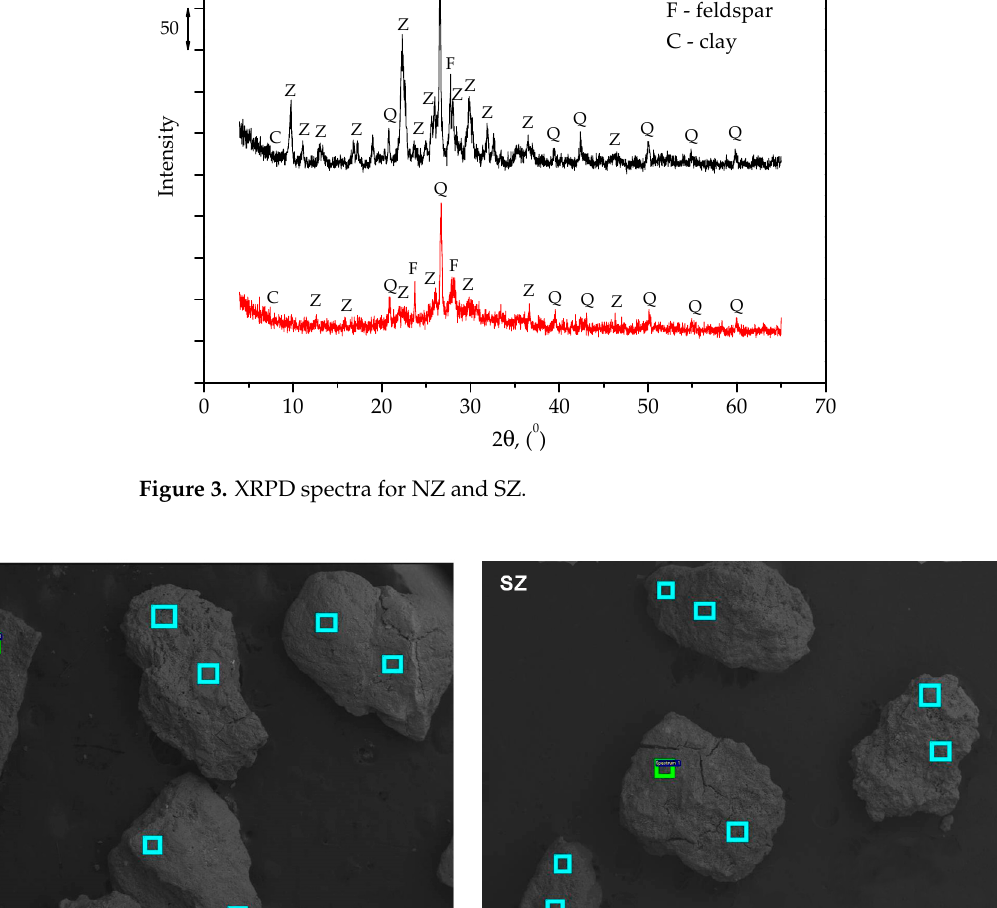
Figure 3. XRPD spectra for NZ and SZ.